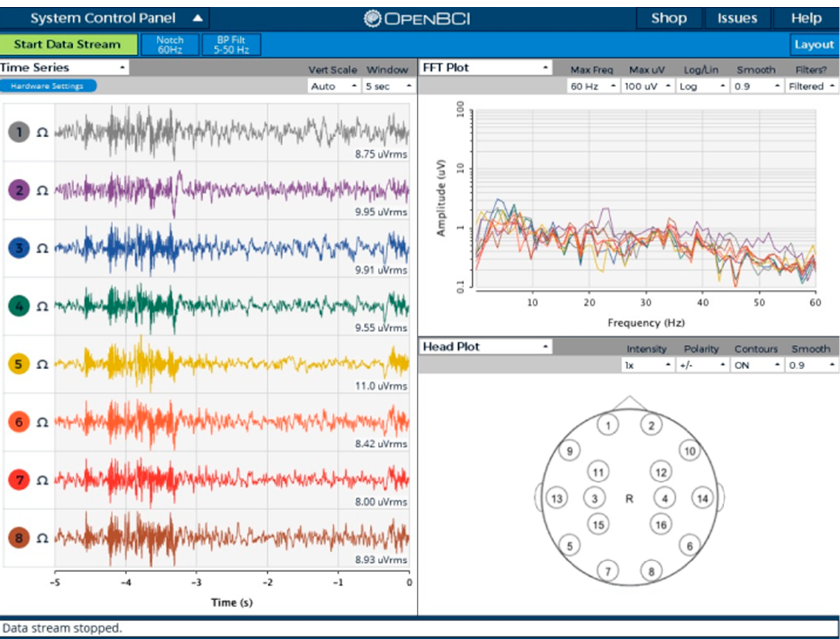
Figure 6. The OpenBCI graphical user interface (GUI) used for validating each ADS1298.